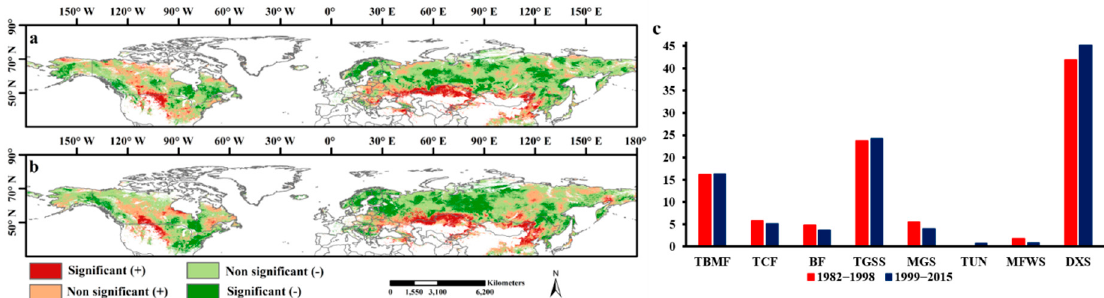
Figure 10. Spatial patterns of drought sensitivity of vegetation during ( a ) 1982–1999 and ( b ) 2000– 2015. Significance of correlations was assessed at p < 0.05. ( c ) showed the proportion of high drought sensitivity areas (significantly positive correlation) at each